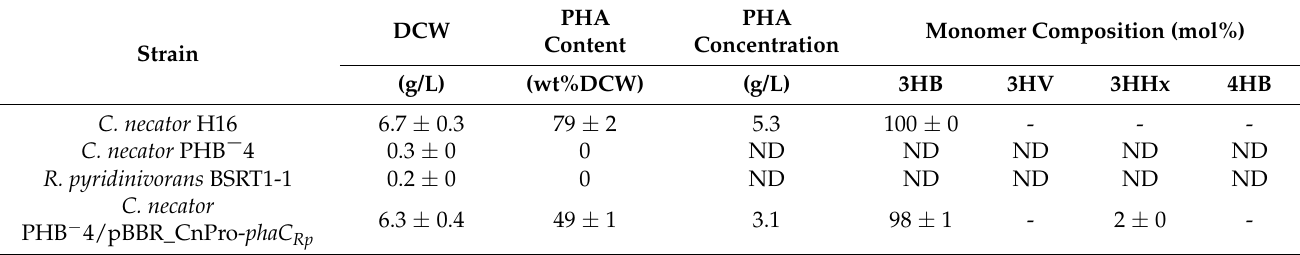
Table 4. Comparison of PHA biosynthesis by C. necator H16, C. necator PHB — 4, R.